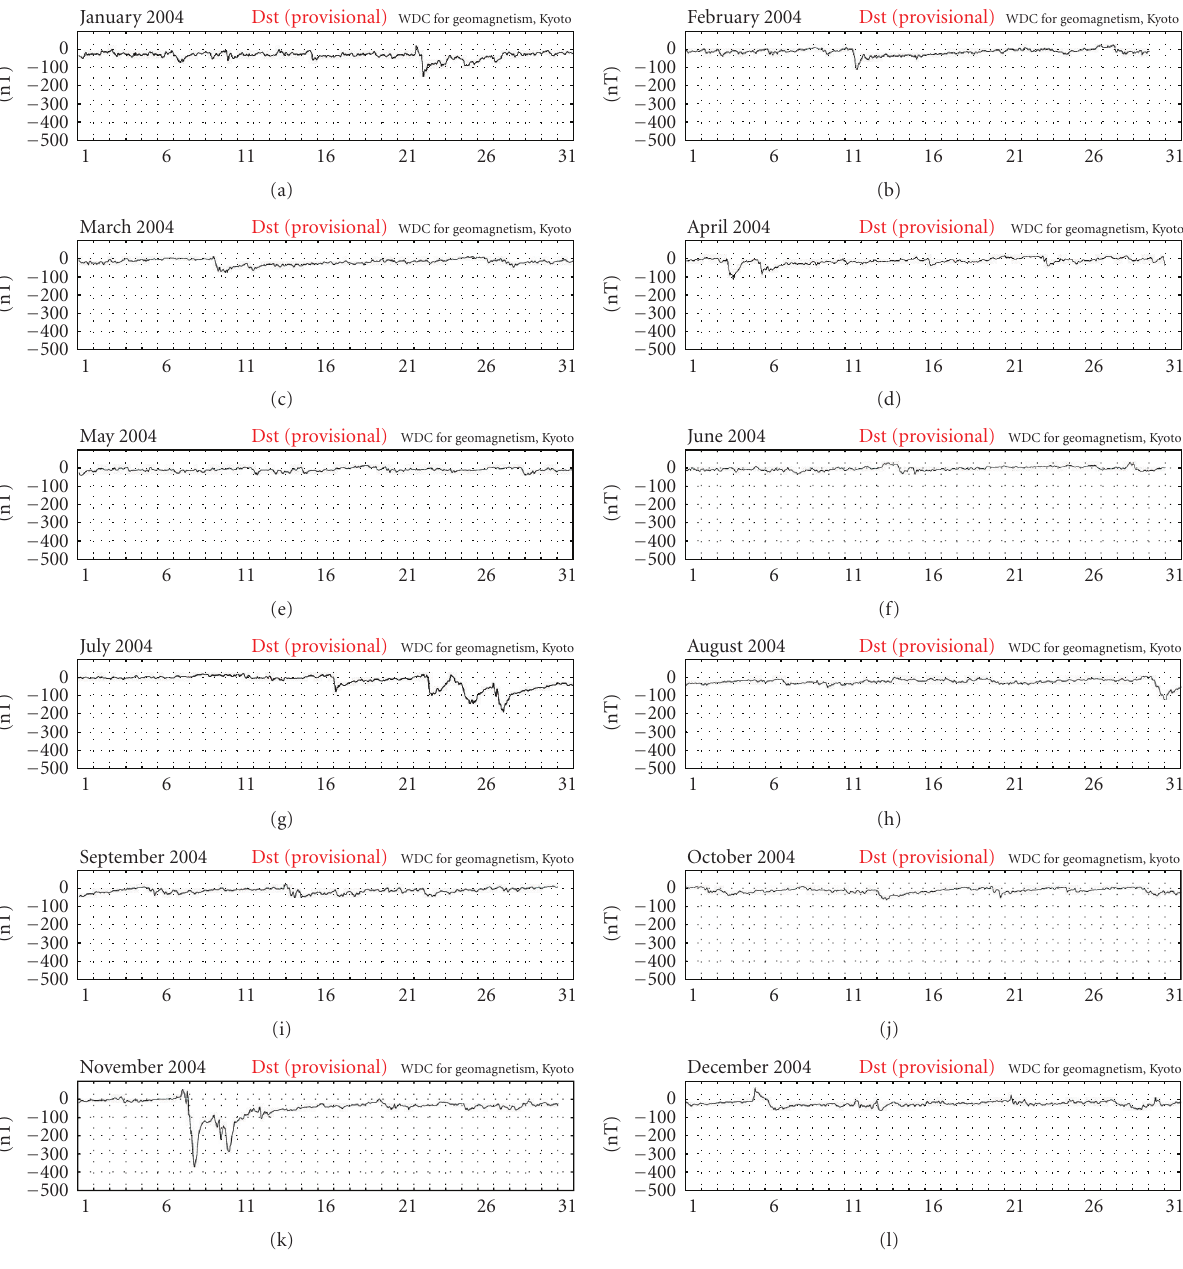
Figure 9: This figure denotes the Dst indices for year 2004 in